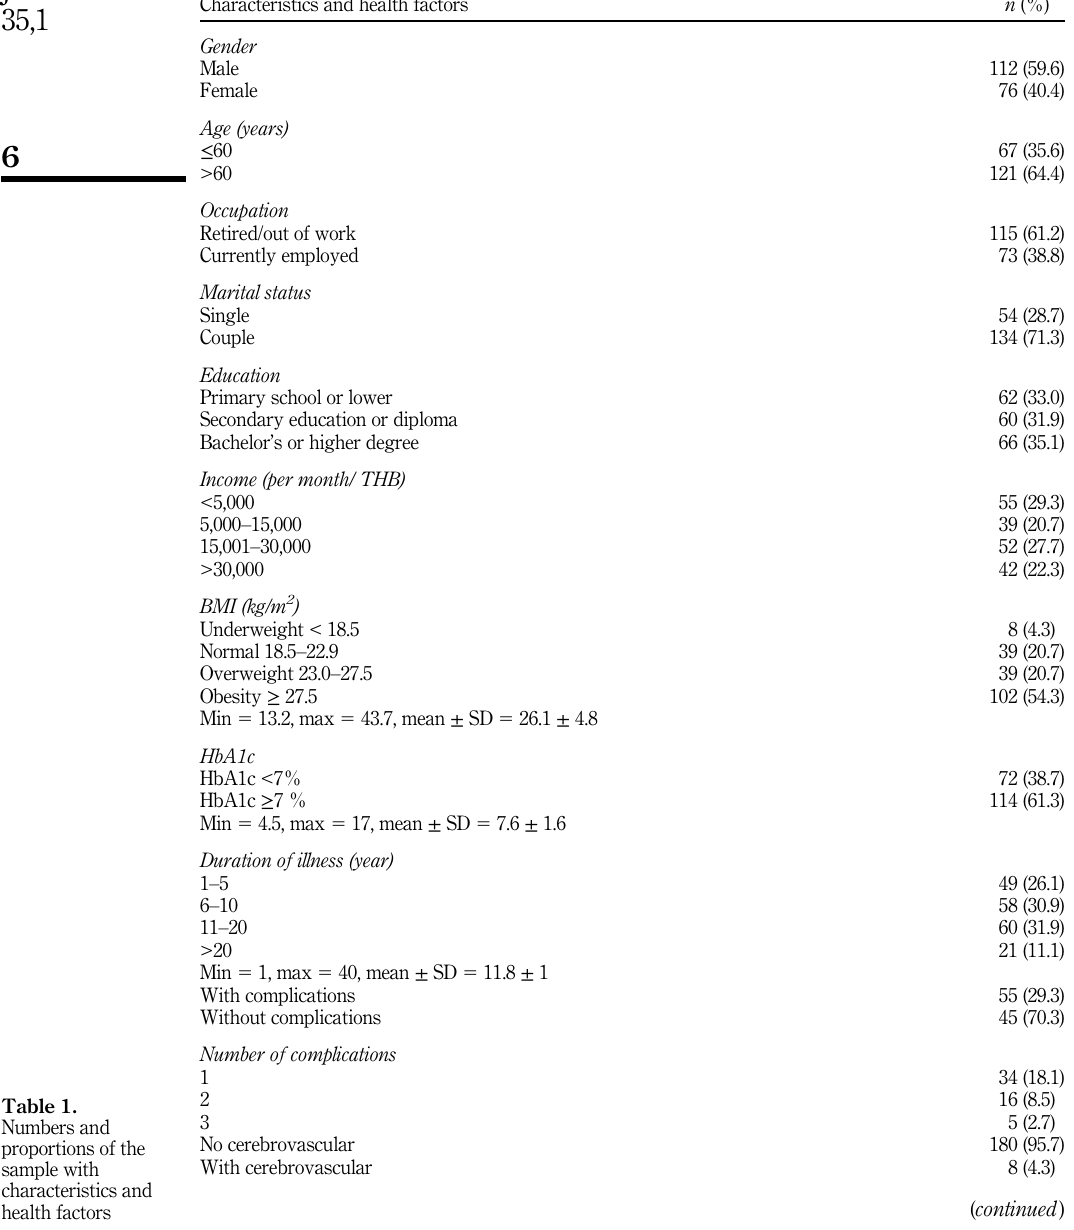
proportions of the sample with characteristics and health